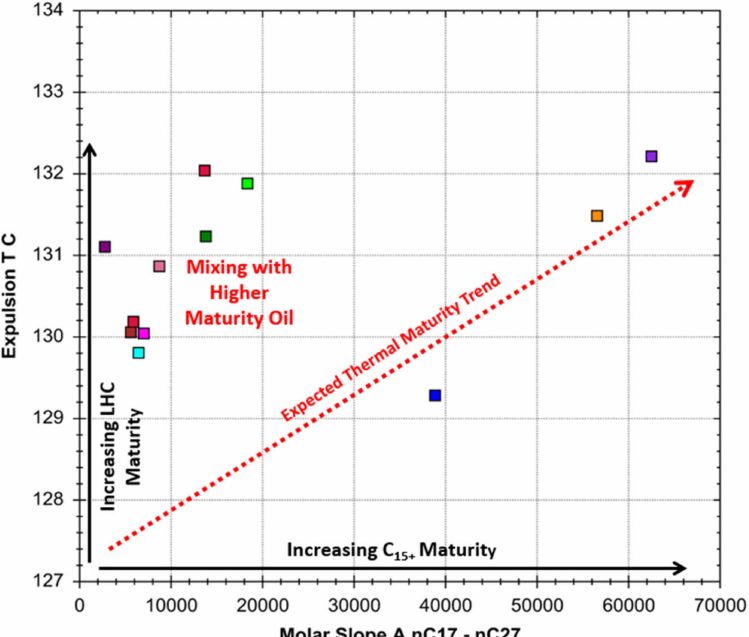
Figure 17. Plot of molar slope A for C 15+ hydrocarbons against C 7 oil generation/expulsion tem- perature for Marcellus Formation condensates produced in the wet gas region (after Adams and Kornacki [54]). The plot indicates mixing of higher maturity light hydrocarbons (LHC) and variable maturity C 15+